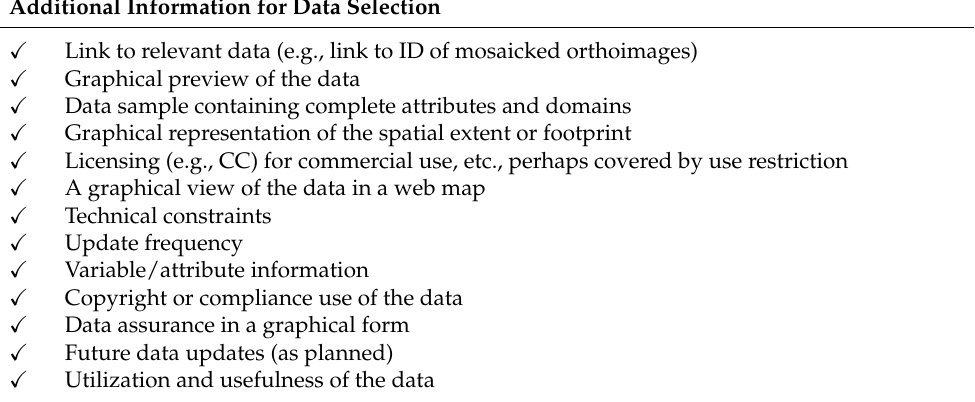
Table 15. Additional information required for spatial data selection. Additional Information for Data